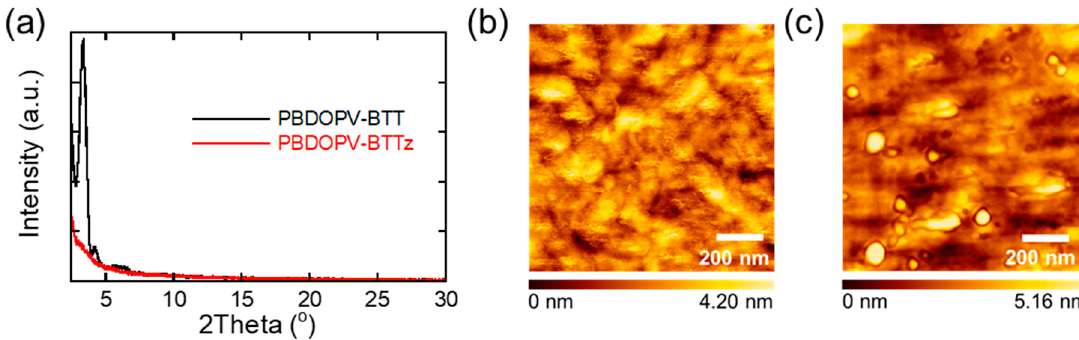
Figure 7. ( a ) Out-of-plane grazing-incidence wide angle X-ray scattering (GIWAXS) patterns of the polymer thin films of PBDOPV-BTT and PBDOPV-BTTz after thermal annealing at 240 and 210 °C, respectively. Tapping-mode atomic force microscopy (AFM) images of ( b ) PBDOPV-BTT and ( c ) PBDOPV-BTTz after thermal annealing at 240 and 210 °C, respectively.